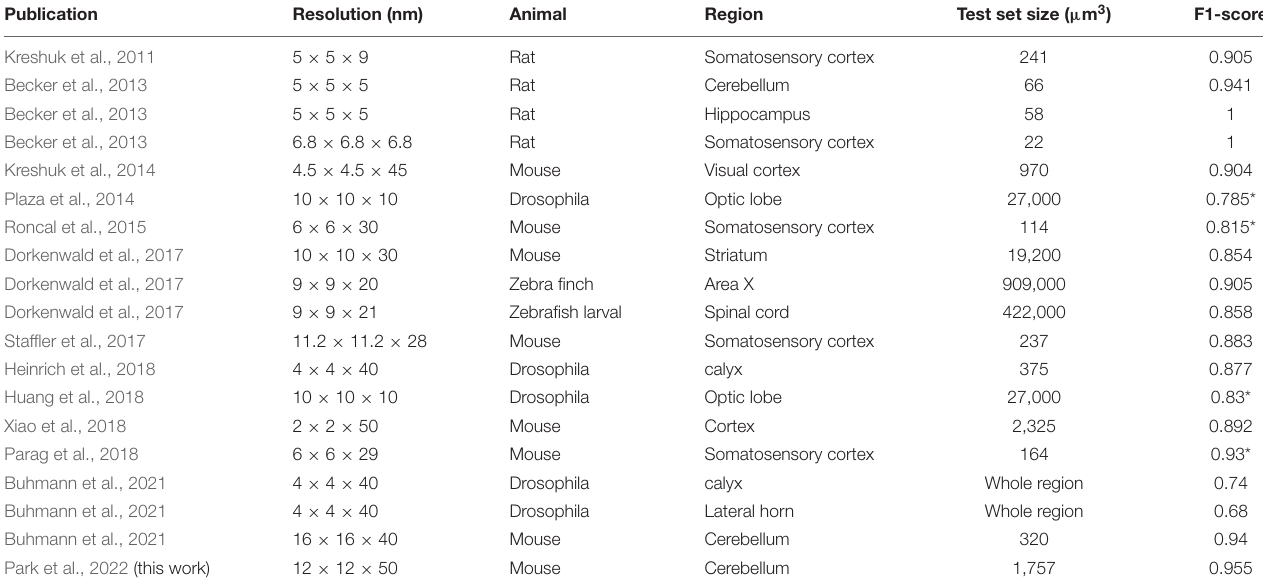
TABLE 1 | Accuracy of various synapse detection methods (selected